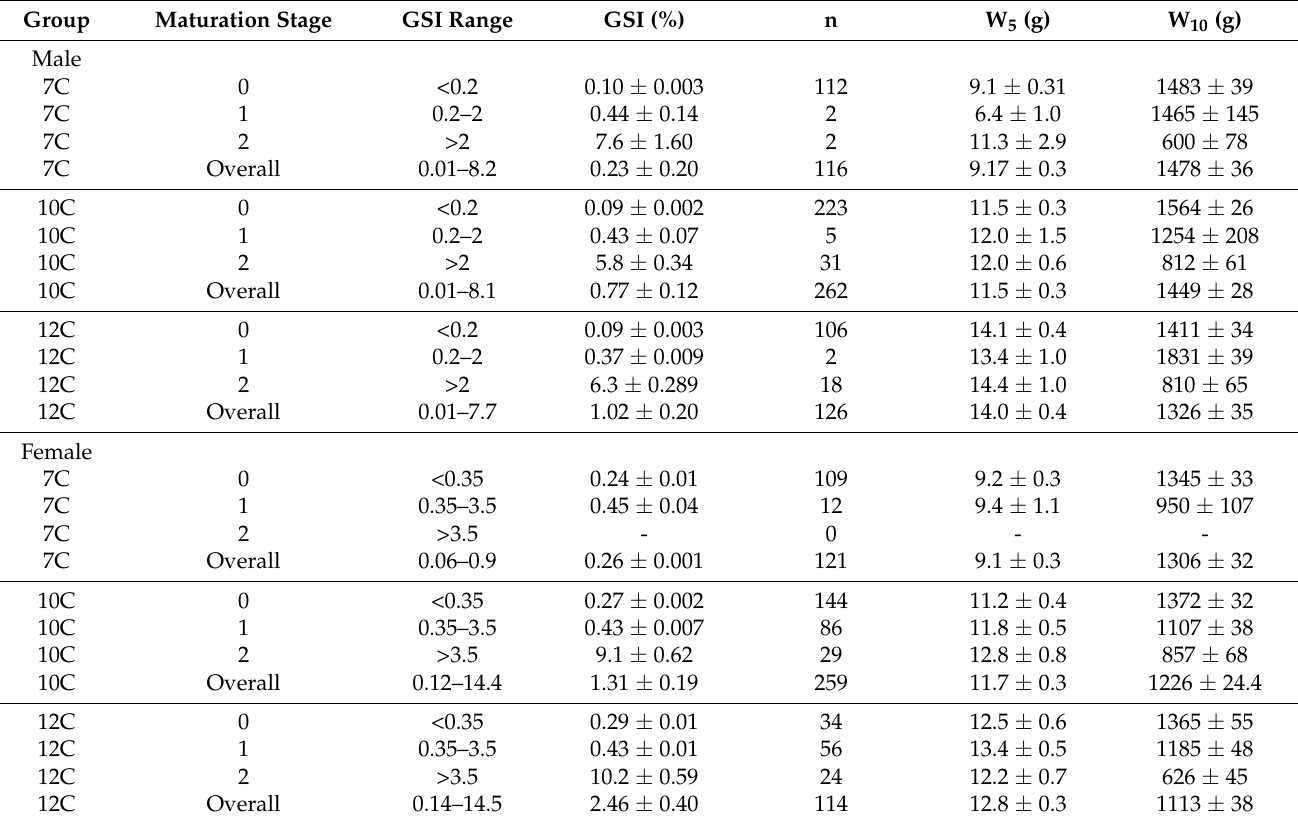
Table 1. Male and female Arctic charr from each group sorted into three maturation stages according to GSI at harvest on day 654. Mean GSI within each maturation stage (GSI), number of fish within each stage (n). Mean body weights (W) ± S.E. at tagging on day 234 (W 5 ) and harvest at day 654 (W 10 ). No males had GSI from 0.6% to 2.0% and no females had GSI from 0.8% to